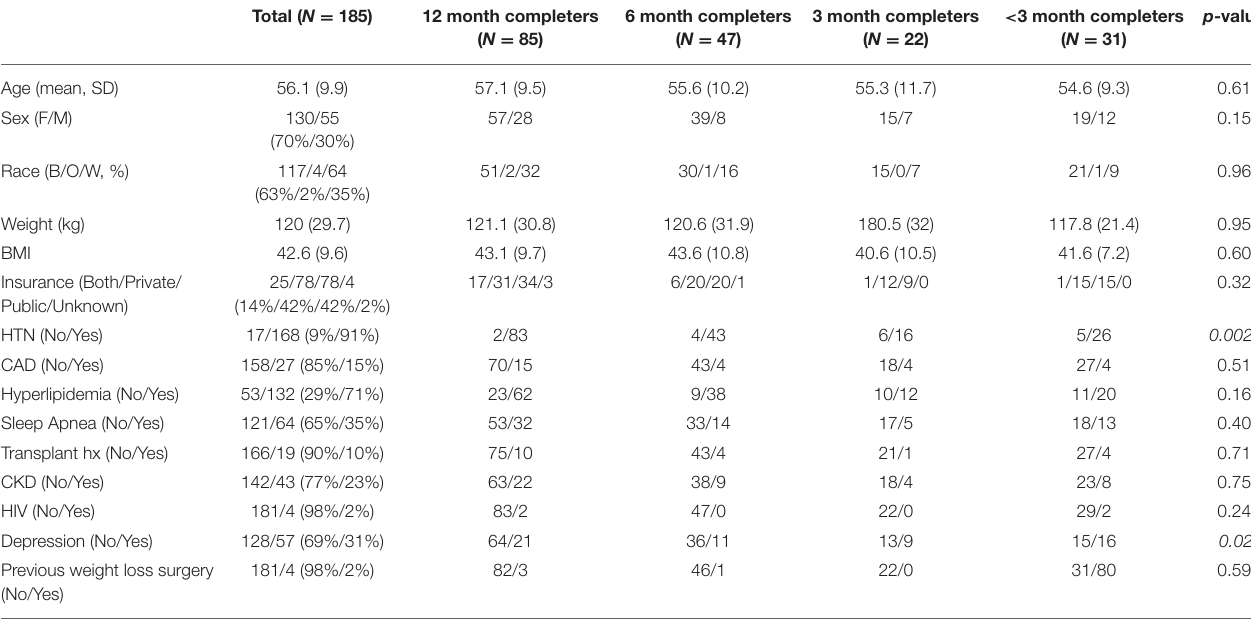
TABLE 1 | Demographic and clinical profile of study